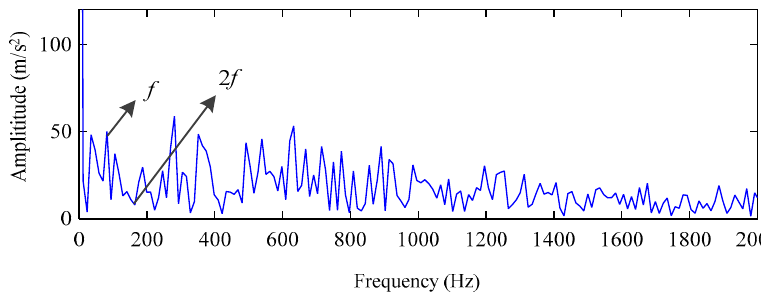
Figure 12. Envelope spectrum of optimal component by using CEEMD.